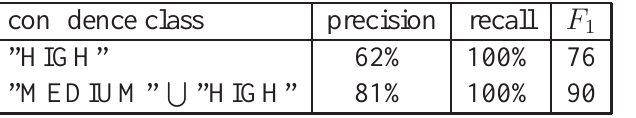
Table 4: Evaluation of LAILAPS relevance ranking